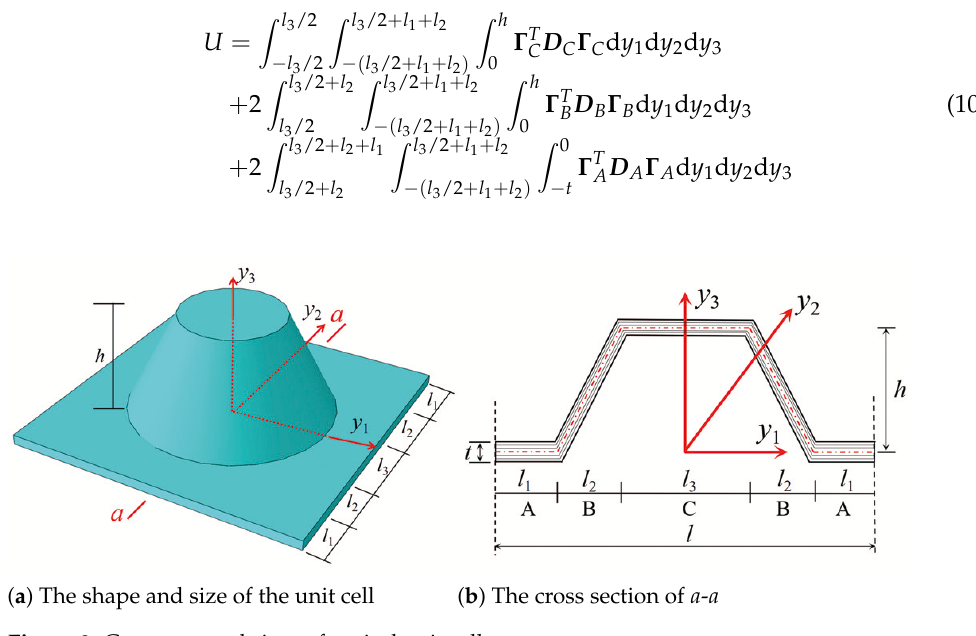
Figure 3. Geometry and sizes of typical unit